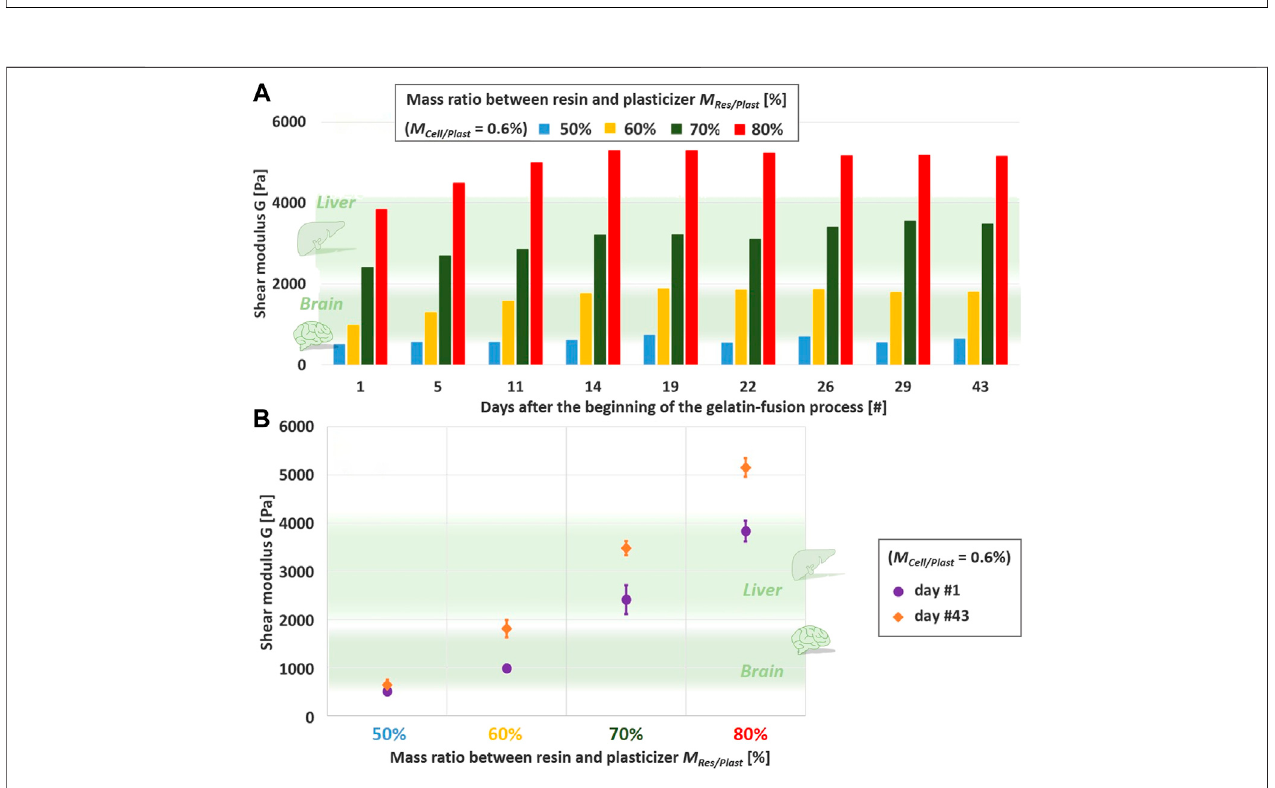
FIGURE 3 | The shear modulus against mass ratio resin to plasticizer is measured with indentation tests over a period of 43 days after gelation-fusion in order to study the stability of the PVCP gels in terms of mechanical properties (A) . Shear moduli measured directly after gelation-fusion process (purple) and after stabilization (orange) are represented against mass ratio between resin and plasticizer, and are compared to liver [64] and brain [59 – 63] values from the literature (B) .